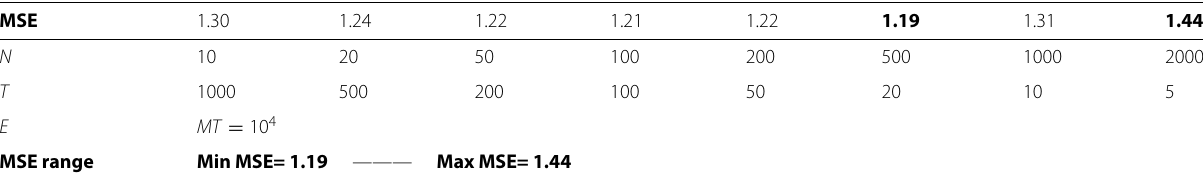
Table 10 Results of the GMS algorithm for the example in Section 6.4